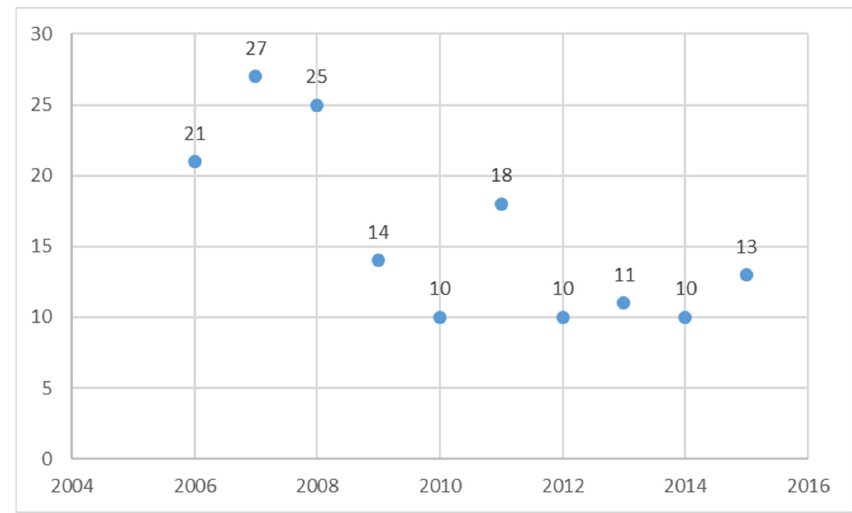
Figure 1. Distribution of M&As with known dates during 2006–2015 in Greece.